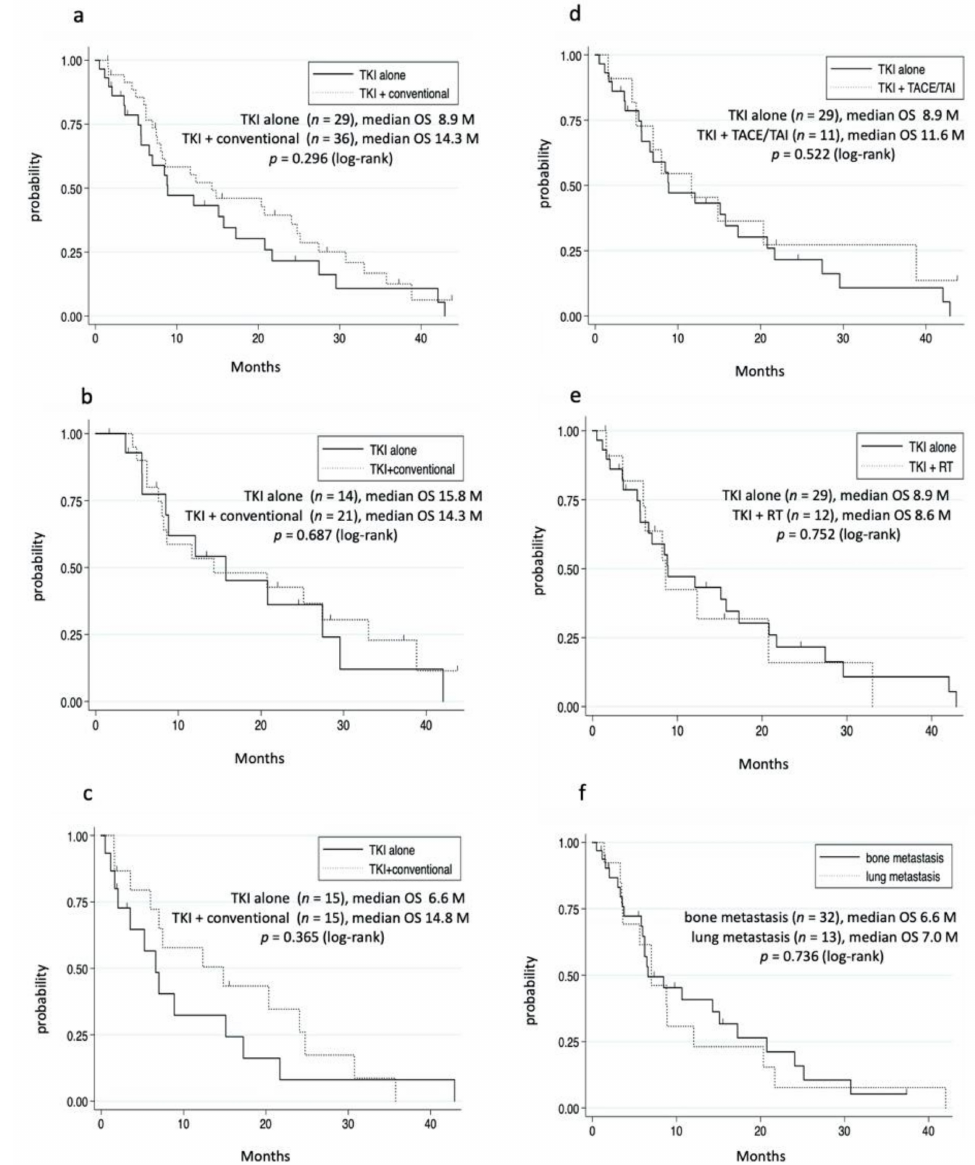
Figure 3. Cumulative survival rate. ( a – c ) TKI alone versus TKI plus conventional therapies. ( a ) All patients in TKI group. In the TKI alone group, survival rates at 1 and 3 years were 46.7% and 10.7%, respectively. In the TKI plus conventional therapies group, survival rates at 1 and 3 years were 55.0% and 12.6%, respectively. ( b ) REFLECT IN. In the TKI alone group, survival rates at 1 and 3 years were 61.8% and 12.1%, respectively. In the TKI plus conventional therapies group, survival rates at 1 and 3 years were 53.2% and 22.7%, respectively. ( c ) REFLECT OUT. In the TKI alone group, survival rates at 1 and 3 years were 32.4% and 8.1%, respectively. In the TKI plus conventional therapies group, survival rates at 1 and 3 years were 57.6% and 0%, respectively. ( d ) TKI alone versus TKI plus TACE/TAI. In the TKI plus TACE/TAI group, survival rates at 1 and 3 years were 45.3% and 27.3%, respectively. ( e ) TKI alone versus TKI plus radiation. In the TKI plus irradiation group, survival rates at 1 and 3 years were 42.4% and 0%, respectively. ( f ) Lung versus bone metastases. In the lung metastases group, survival rates at 1 and 3 years were 30.6% and 7.5%, respectively. In the bone metastases group, survival rates at 1 and 3 years were 40.7% and 5.1%,